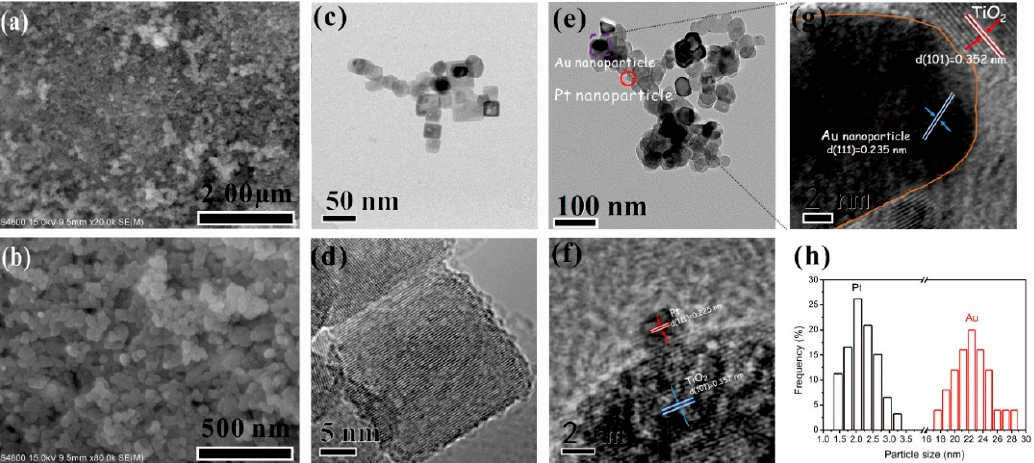
Figure 1. SEM image of Au 2 Pt 2 /N–TiO 2 ( a , b ) and TEM and high-resolution TEM (HRTEM) images of N–TiO 2 ( c , d ) and Au 2 Pt 2 /N–TiO 2 ( e – g ). Nanoparticle size distributions of Au and Pt in Au 2 Pt 2 /N–TiO 2 ( h ). Scale bar ( e , f ): 2 nm.